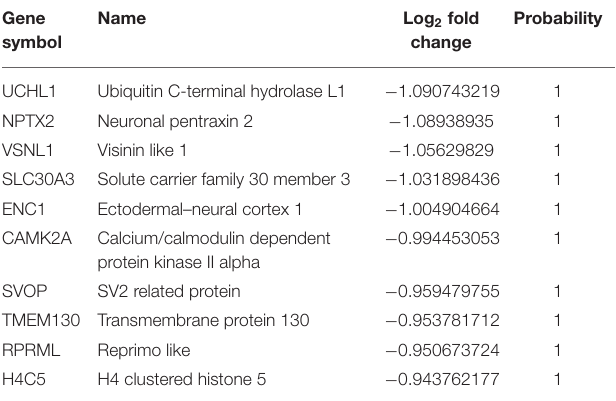
TABLE 3 | The top 10 downregulated genes in AD vs. control samples.